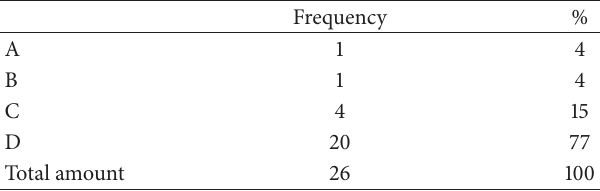
Table 2: Best results according to O’Kelly-Marotta grading scale.